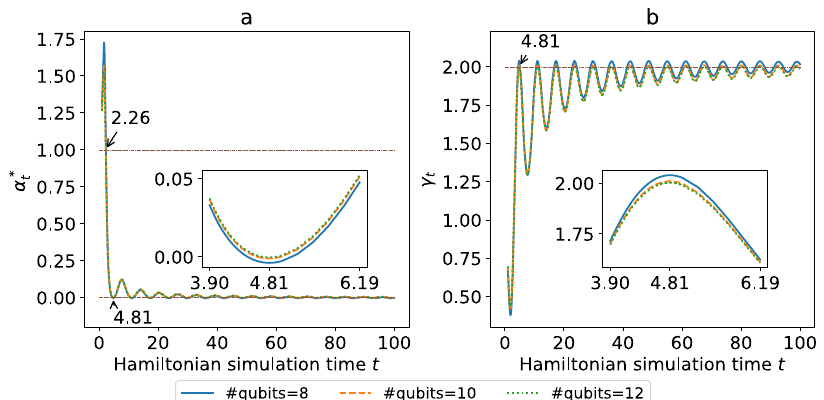
Fig. 4 Quantities relevant to the system linear cross-entropy heavy output generation (sXHOG) problem, evaluated using the explicit expressions given in Supplementary Note 10. a The threshold fi delity α (cid:6) as a function of Hamiltonian simulation time t . The upper value t noted on the plot indicates the time value t thr ≈ 2.26 where α * ( t thr ) = 1. The lower value noted on the plot indicates the regime at fi nite time t opt ≈ 4.81 with the fi rst minimal value of threshold fi delity. b The parameter γ t as a function of Hamiltonian simulation time t . The value noted on the plot indicates the value γ t ≈ 2 at the optimal time t opt ≈ 4.81. The averages in ( a ) and ( b ) are estimated numerically from ~100 instances and γ t near of the mQSVT circuit encoding random Hamiltonians drawn from the Haar measure. Insets in each panel show the behavior of α (cid:6) t the optimal time t opt ≈